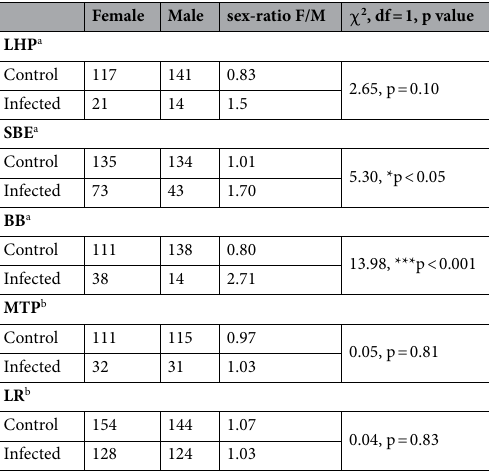
Table 2. Sex ratio (female number/male number) in control and infected groups for each strains of Ae. aegypti (LHP, SBE, BB) and Ae. albopictus (MTP, LR) (*p < 0.05; ***p < 0.001; Chi-squared test). a Aedes aegypti ; b Aedes